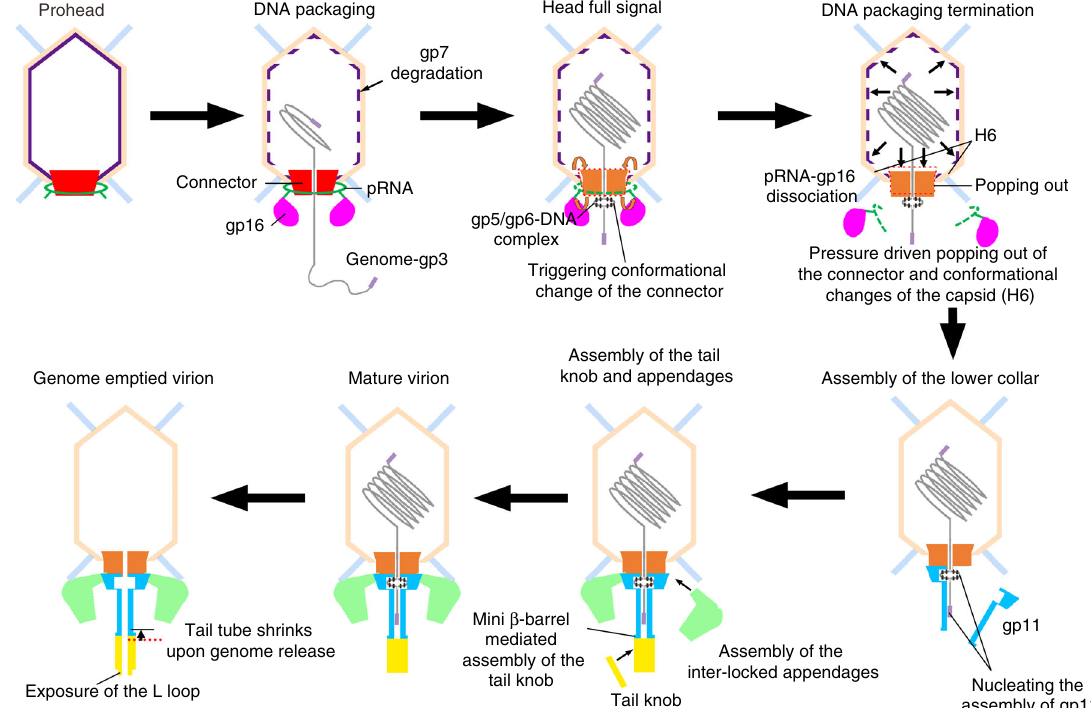
Fig. 9 A schematic diagram showing the assembly, maturation, and infection of the bacteriophage ϕ 29. Molecular details are illustrated for the dsDNA packaging, dsDNA packaging termination, assembly of the lower collar, tail knob and tail appendages, and genome ejection of the bacteriophage ϕ